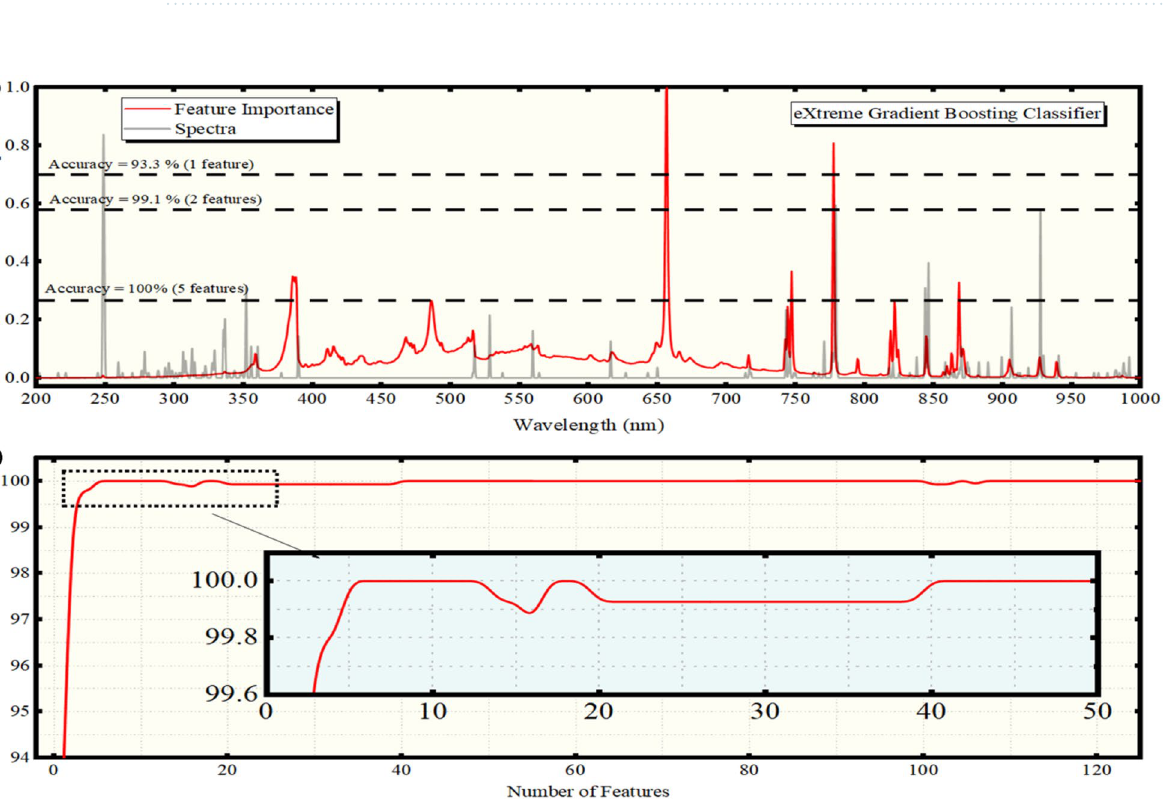
Figure 4. ( a ) Feature importances (gray line) versus wavelength resulting from the XGBoost algorithm. An experimental LIBS spectrum (red line) is shown for comparison. The horizontal dashed lines indicate the number of features threshold and the corresponding computed accuracies. ( b ) Prediction accuracy using the XGBoost algorithm versus the number of